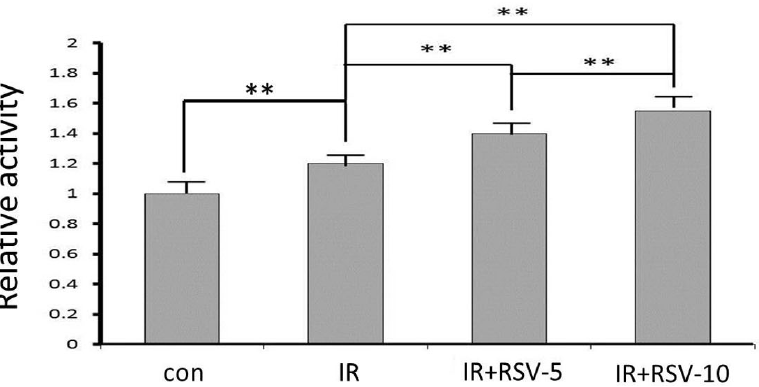
Figure 4. Sirt1 enzyme activity after IR and resveratrol treatment. Activity of Sirt1 enzyme was measured in total protein extracts from hippocampal tissues of rats subjected to RSV or IR procedure. Results were normalized to control levels, and the significance was calculated by the unpaired t test with the Welch correction. ** p <